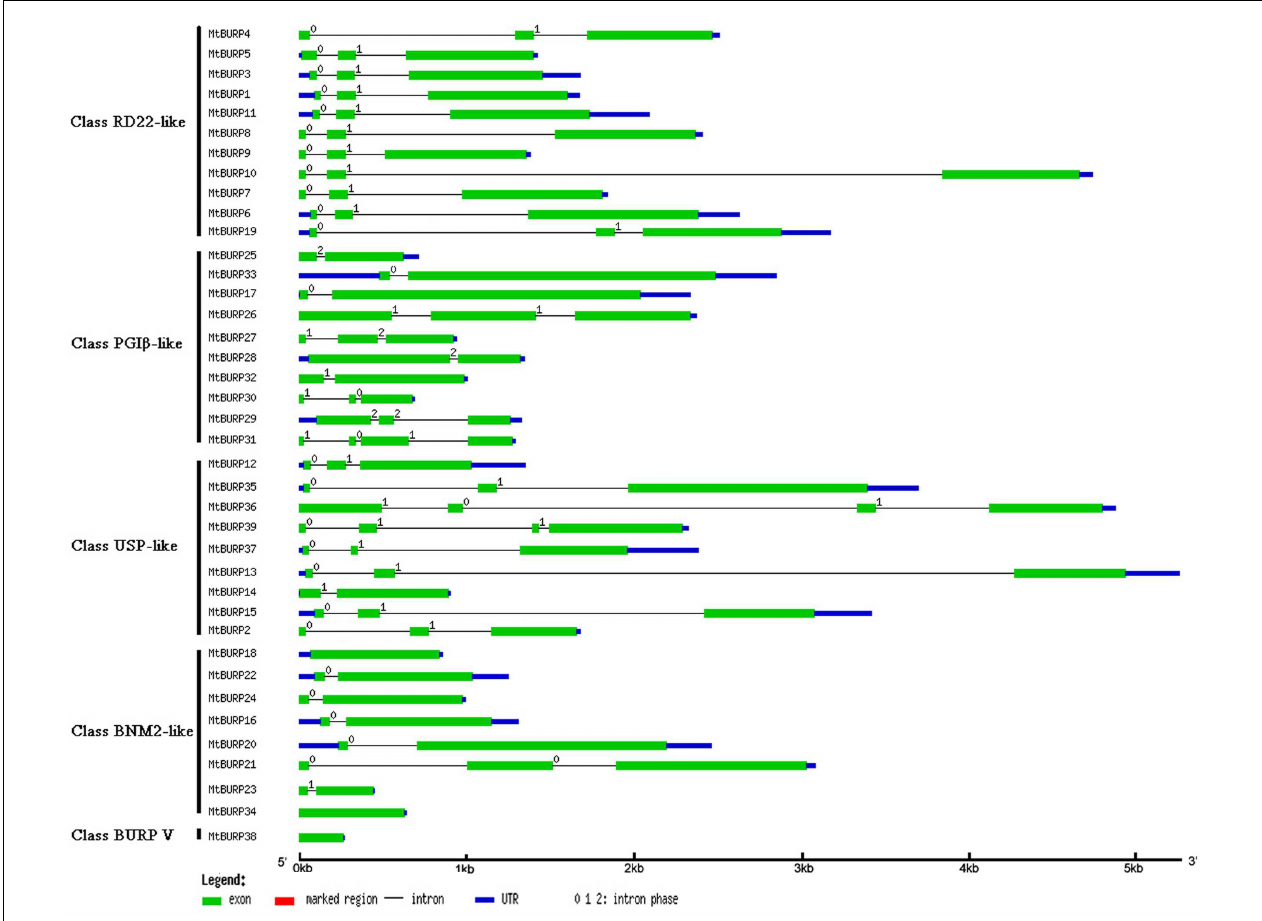
FIGURE 3 | The structure of exon-introns in MtBURP genes. Exons, intron and UTRs are indicated with different colored lines. The length of each MtBURP gene can be estimated using the scale at the bottom of the figure.